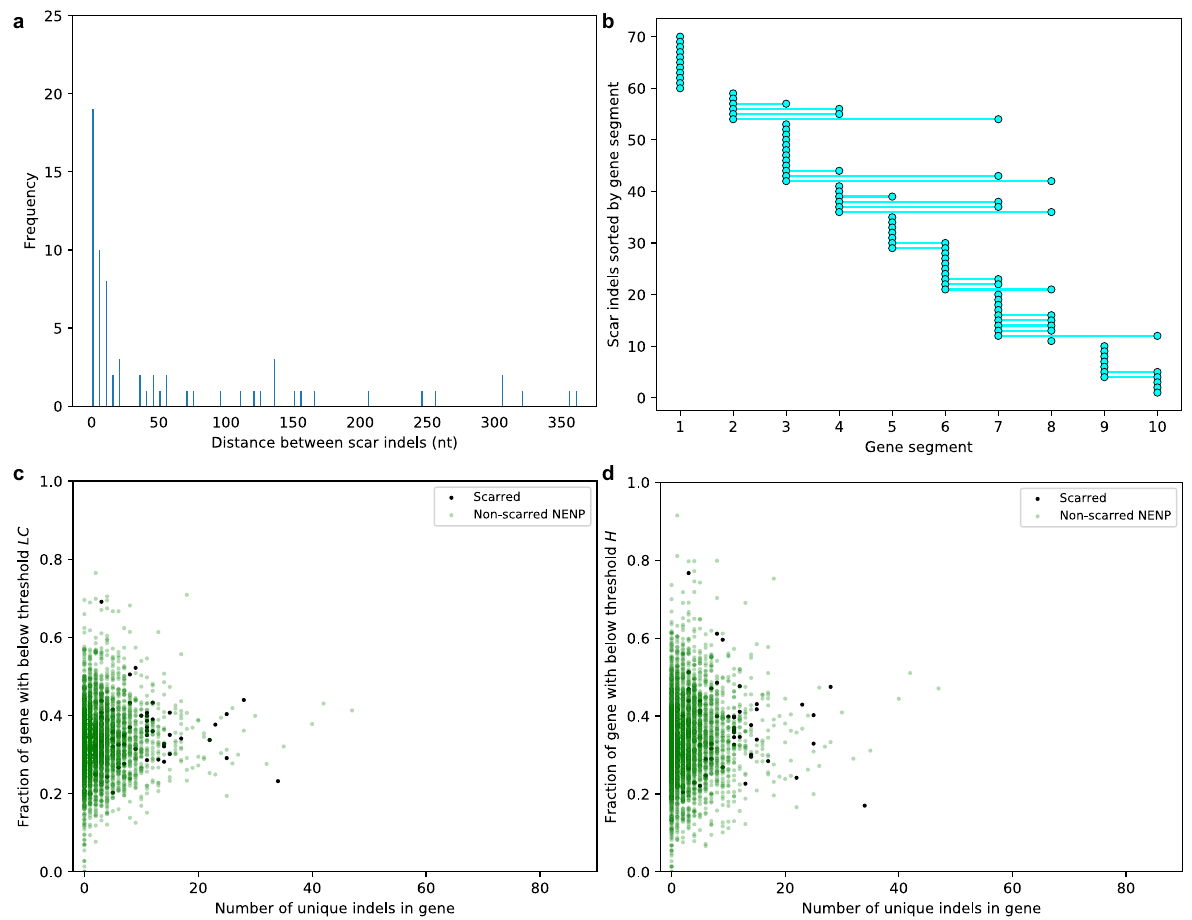
Fig. 5 Indel properties of frameshift scarred genes. a The distribution of distances between indels that together form a scar. In the 69 scars that resulted from exactly two indels, the majority had a distance of <10 nucleotides between the two indels. b Gene segments are shown for indels in scars that had exactly two indels. Each gene is divided in ten equal segments to show the locations of scar indels in the genes. Each indel is shown as a fi lled cyan circle and the two scar indels are connected by a cyan line if they occur in different gene segments. The absence of a cyan line indicates that both indels occurred in the same gene segment. 86% of these 69 frameshift scars had both the frame-shifting and frame-restoring indel in the same or neighboring gene segment. c and d The gene-fraction below threshold complexity scores is shown for scarred genes (black fi lled circles) and the non-essential and non-PE- PPE genes that do not have scars (non-scarred NENP, faded green circles), with c showing data for LC and d showing data for H . The threshold scores ( H = 0.932, LC = 0.551) are the lowest H/LC scores in the indel pockets in Fig.